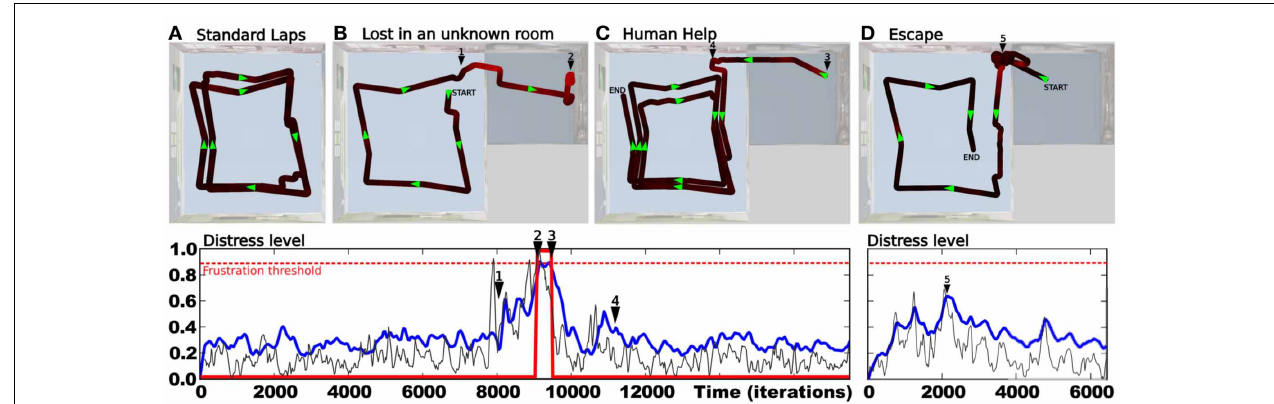
FIGURE 9 | Simultaion highlighting the need for a frustration mechanism (see Setup 1, Figure 6). Up: (A) Trajectory after performing some laps autonomously without disturbance. (B) The supervisor suddenly interferes to deviate the robot into the second room (1). The robot tries to perform its task without success. The distress level increases progressively while there is no consistency in the perceived sensory-motor sequence. Finally, the system stops and call for help (2). (C) The supervisor assists the robot by pulling it in the right direction to escape this room (3). The system